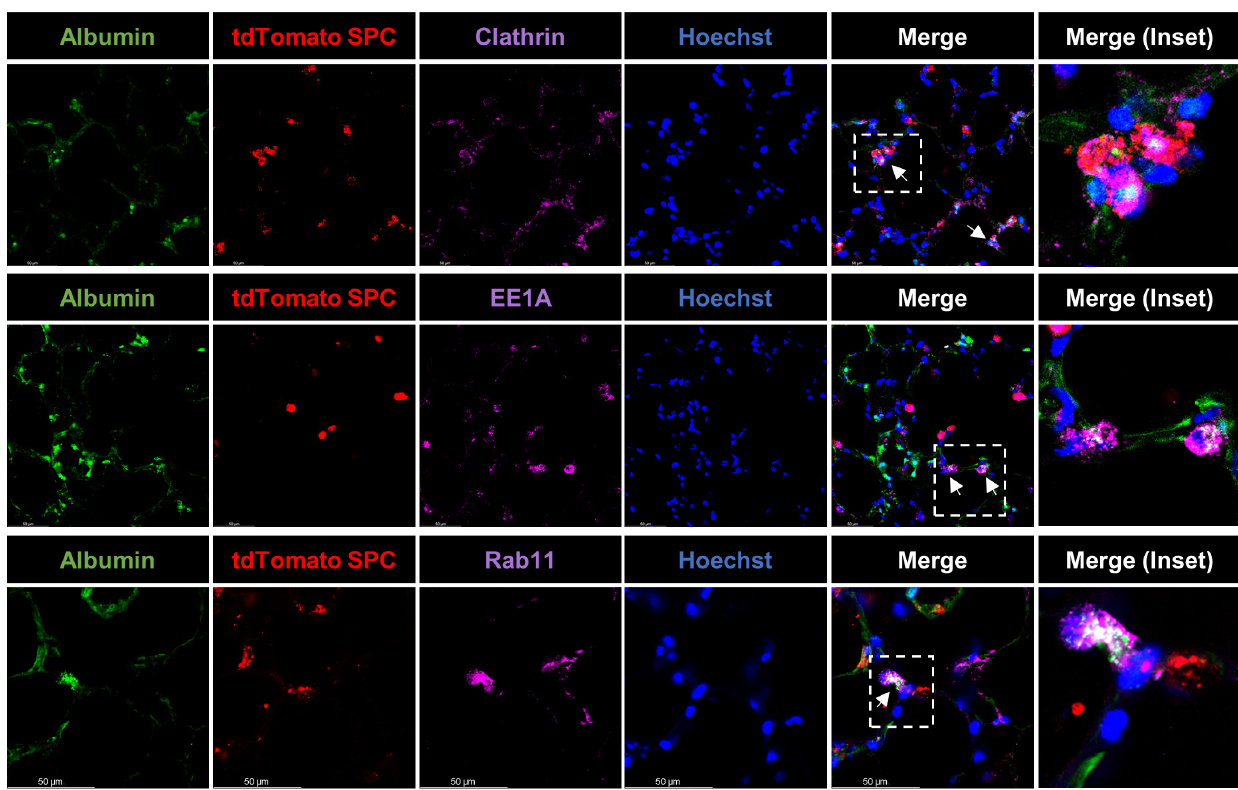
Figure 5. Albumin distribution upon endocytosis in PCLS: Murine PCLS from Sftpc CreERT2/+ : tdTomato flox / flox mice were treated with AlexaFluor488-albumin (250 μ g/mL final concentration) for 60 min, fixed, and then analyzed by confocal microscopy. Representative images of immunofluorescence staining of tdTomato-surfactant protein C (SPC)-expressing ATII cells (red), clathrin, early endosome antigen 1 (EE1A, a marker of early endosomes), or Ras-related protein (Rab11, a marker of recycling endosomes) (all magenta), albumin (green), and nuclei (blue) are shown. The dashed line boxes mark the insets. Co-localization of AlexaFluor488-albumin with the above-mentioned endocytic/trafficking markers (white) is indicated by arrows. Scale bar − 50 μ M.